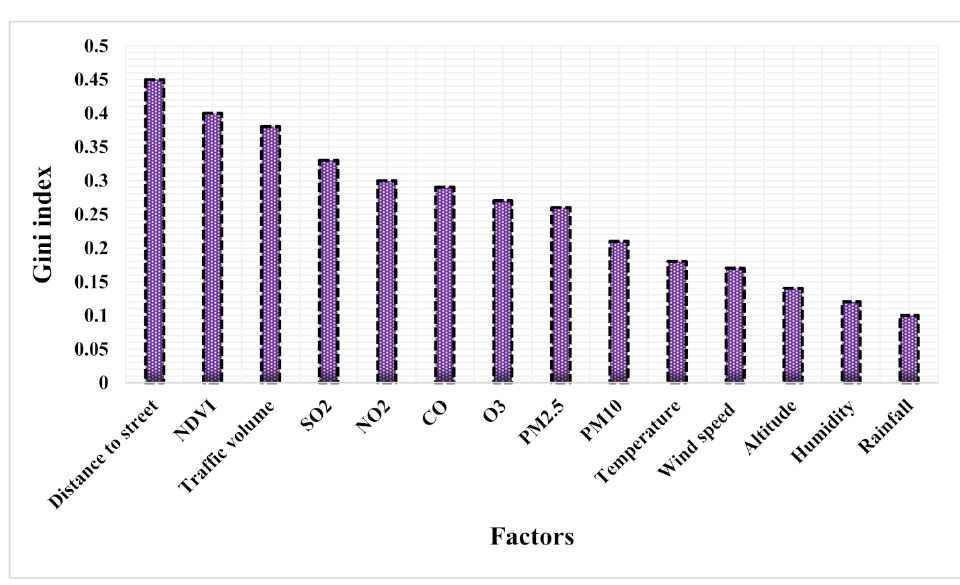
Figure 4. Result of Gini